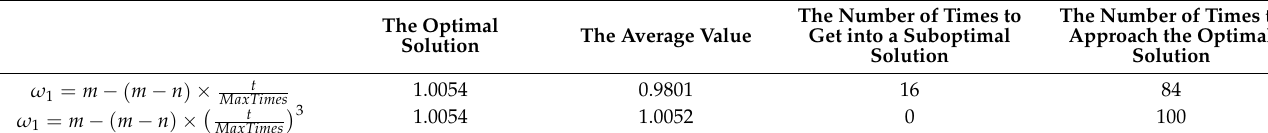
Table 2. Performance comparison of different inertia weights.